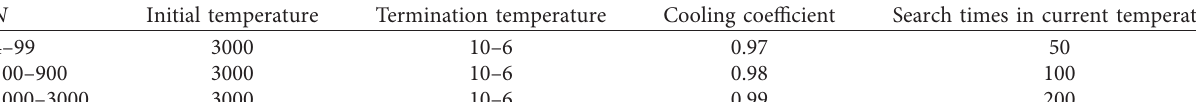
Table 1: Parameter setting of simulated annealing algorithm.